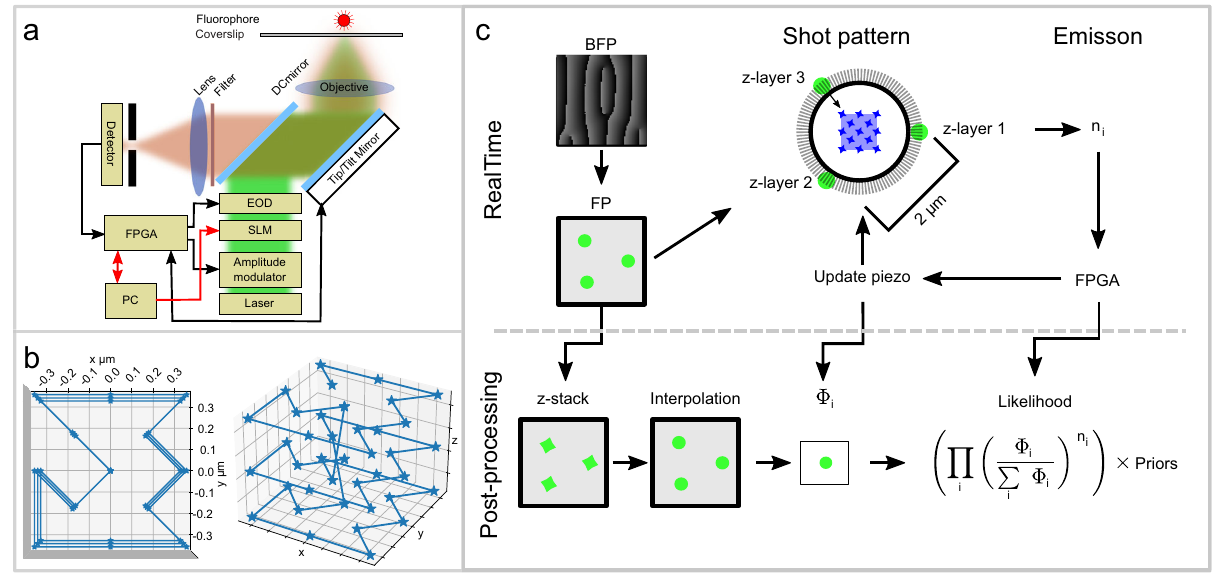
Fig.1|Opticalsetupandtrackingconcept.a Illustrationoftheopticalsetup,laser excitation path with amplitude modulation, spatial light modulator (SLM) for PSF engineering,andelectro-opticde fl ectors(EOD).Followingtheexcitationlightpath after the dichroic mirror, a piezo-driven tip/tilt mirror scanner is used for long- range scanning, the light path ends with an objective and sample. Collected fl uorescence is de-scanned by the tip/tilt mirror and passed through the dichroic mirror, fl uorescent fi lters, and ends with a confocal detection based on single photoncountingavalanchephotodiodes. b TrackingpatterncreatedbytheEOD ʼ